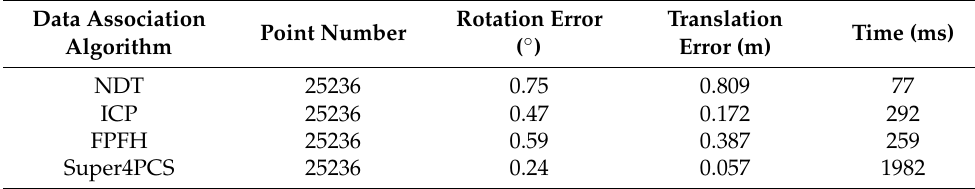
Table 3. Registration results of four data association algorithms.